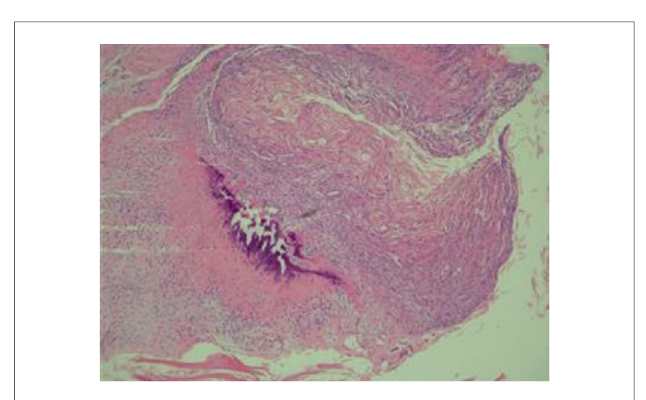
FIGURE 4 Histopathological examination revealing a wall of strati fi ed squamous epithelium and keratinized material inside a cyst.